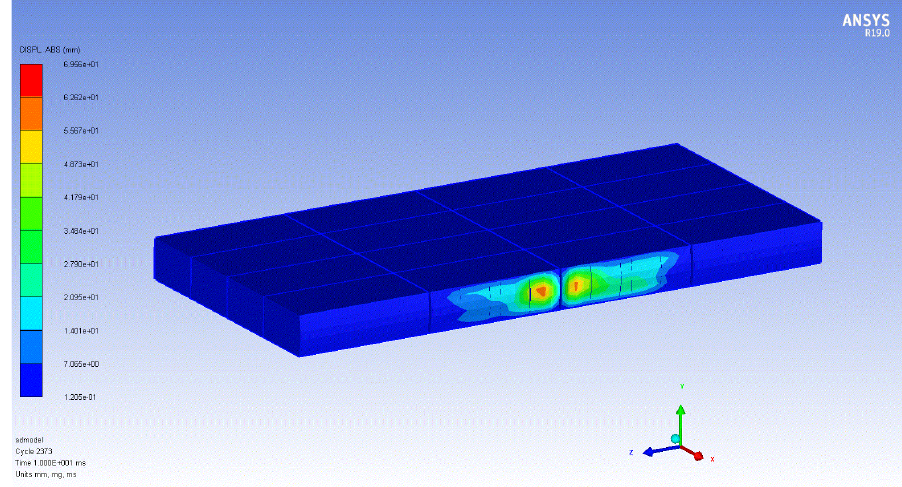
Figure 21. Total deformations of the fortified ferry. The maximum value of the total deformations was found to be 6.9 cm, which is lower than the used curvature of the mitigation panel (7.5 cm). Figure 22 illustrates the response of the floating ferry subjected to an explosion of 10 kg of TNT after installing the mitiga- tion system.